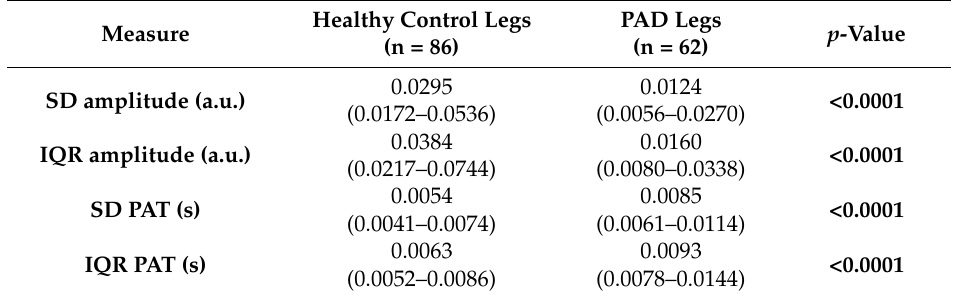
Table 3. Toe time-domain variability results comparing PAD and healthy control. Median (IQR) values are shown. a.u.: Arbitrary